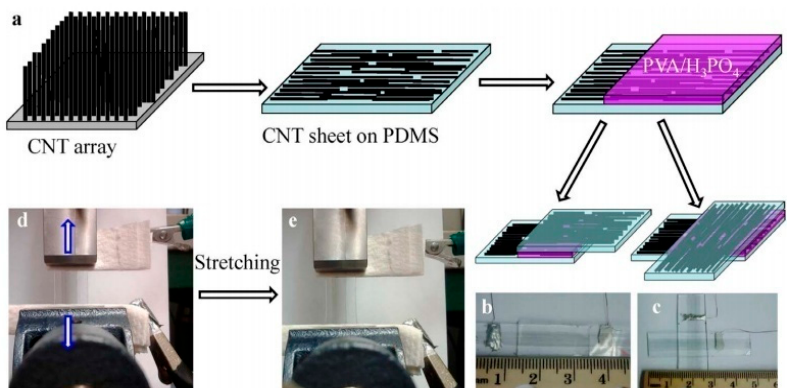
Figure 5. Diagram of the fabrication process for the transparent super capacitors and their optical images. ( a ) Schematic illustration of the process for fabricating the transparent and stretchable super capacitor. ( b , c ) Photographs of super capacitors assembled in the parallel and cross configurations. ( d,e ) Photographs of a super capacitor before and after stretching [66]. Copyright 2014, Nature Publishing Group.